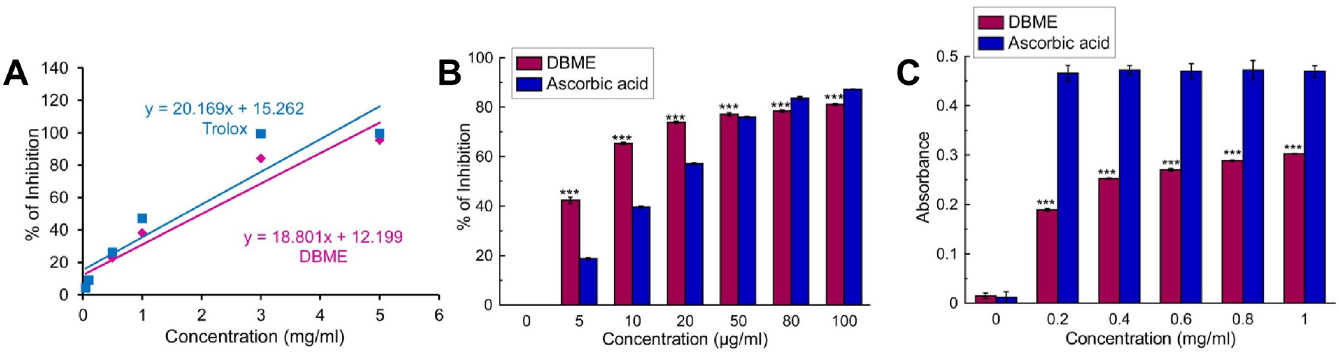
Fig 1. Total antioxidant activity and reducing power of DBME and the reference compounds. (A) total antioxidant activity, (B) DPPH radical scavenging, (C) reducing power activity. The results are mean ± S.D. of six parallel measurements. *** p < 0.001 vs. 0 μ g/ml.